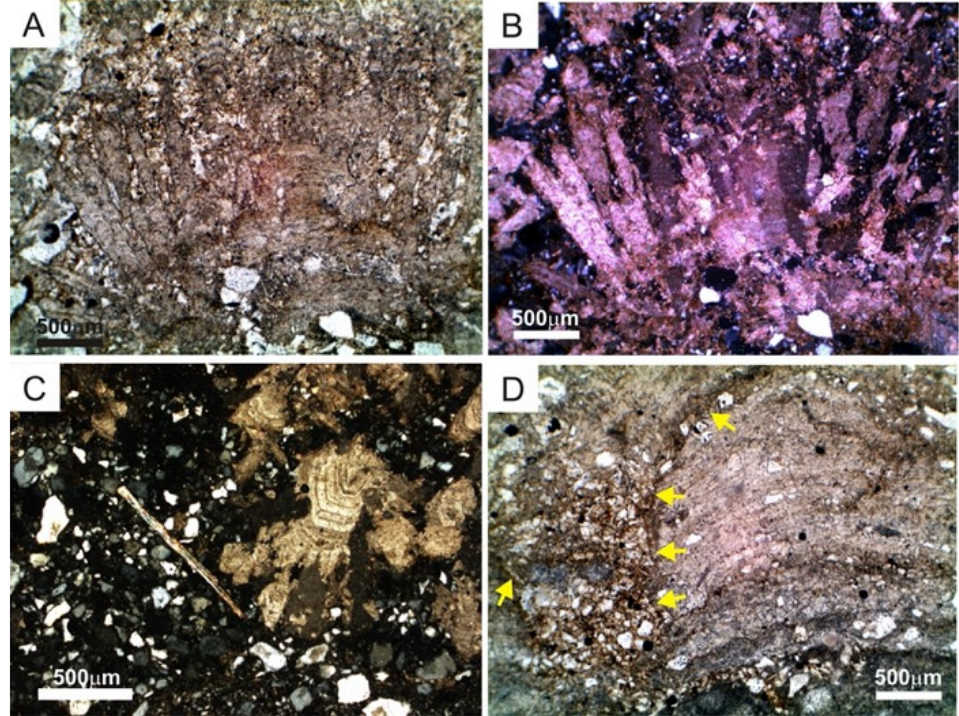
Figure 8. Microphotographs of feature characteristics of sparitic crusts: ( A , B ) columnar fabric composed of elongate calcite crystals with irregular boundaries, some of them dissolved and filled by detrital grains (Sample 304); ( C ) detail of arborescent-zoned calcite crystals (Sample 304); ( D ) detail of erosive contact (arrows) between sparitic laminar layers and overlaying sandy micritic crust (Sample 696). Microphotographs ( A , C , D) were taken under plane-polarized light; ( B ) was taken under crossed nicols.